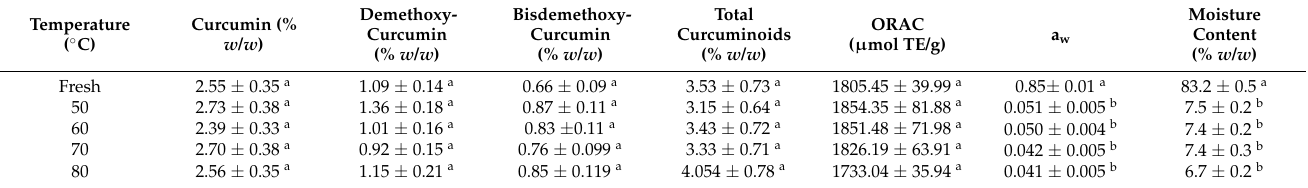
Table 3. Effects of drying temperature of FBD on curcuminoid content and antioxidant capacity in turmeric powder and fresh